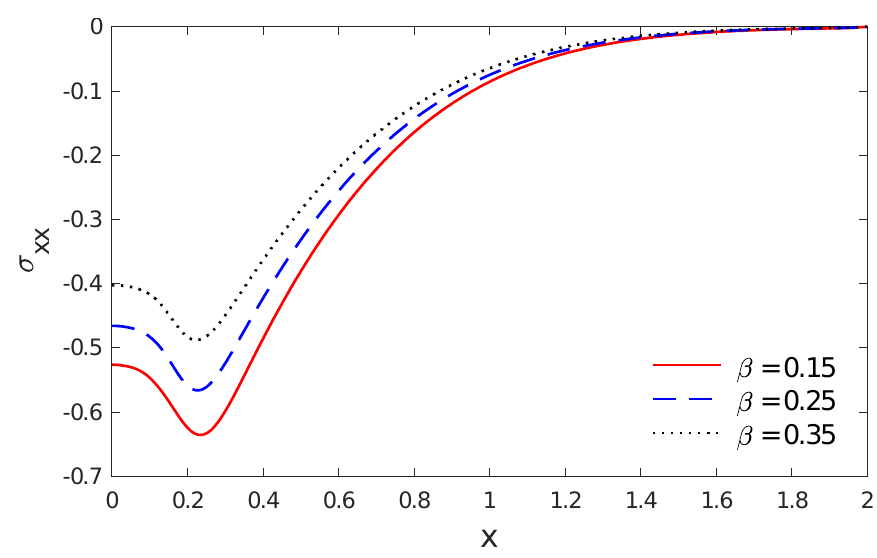
Figure 5. The variations of solid stress 𝜎 𝑥𝑥 versus 𝑥 for several values of porosity.